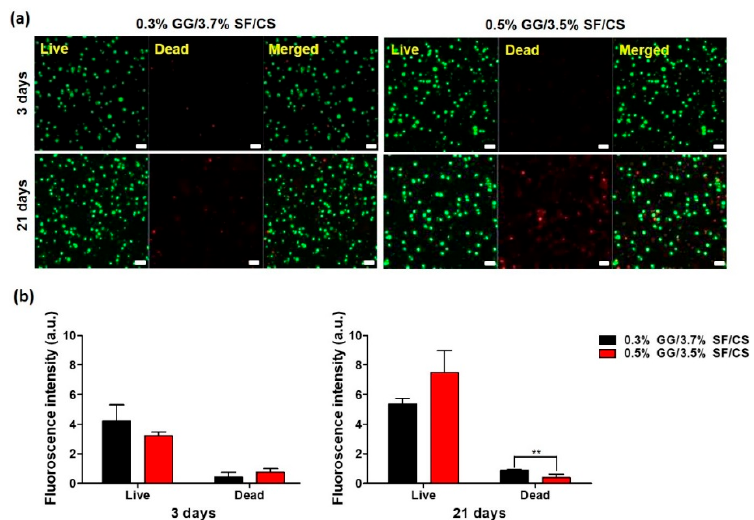
Figure 5. Cytotoxicity analysis of the cell-laden hydrogels: ( a ) live/dead staining images of chondrocytes-encapsulated hydrogels analyzed with the Z-stack mode, and ( b ) relative intensity of live/dead images evaluated with ImageJ software (scale bar = 50 μ m) (values are mean ± SD, n = 3, p < 0.01 (**)).